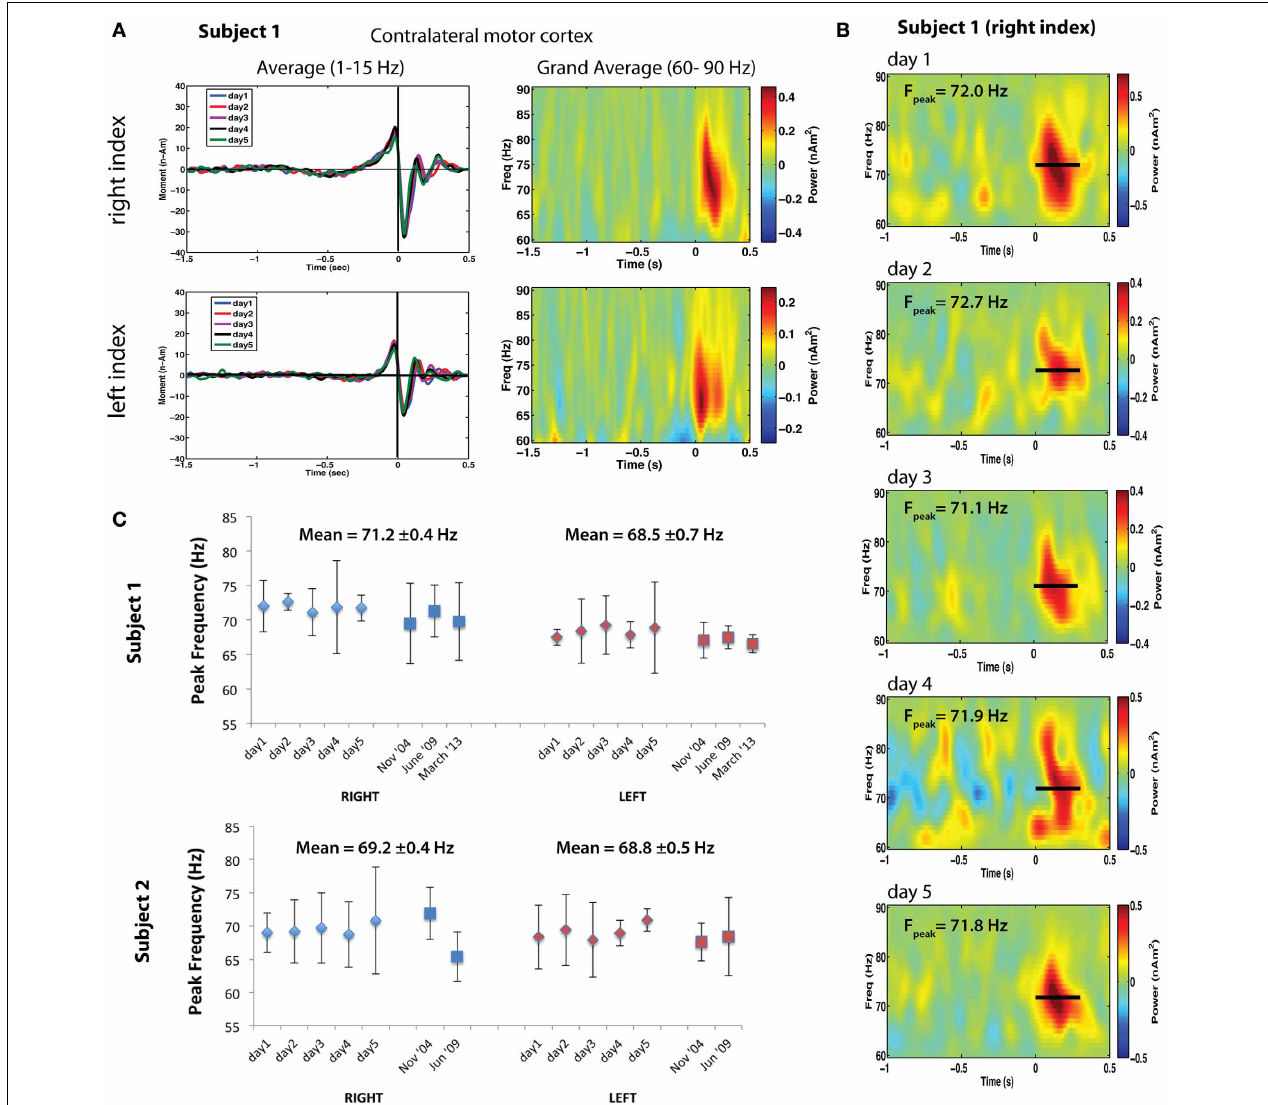
markers) and left index finger (LEFT, red markers) movements repeated for 5 sessions over a one-week period for two subjects. Sessions taken at different time intervals separated by approximately 4–5 years are also shown. Each data point indicates the bootstrap resampled mean peak frequency, using 5000 re-samplings of two-thirds of the single trial time-frequency estimates. Error bars indicate the 95% confidence intervals based on the bootstrap standard